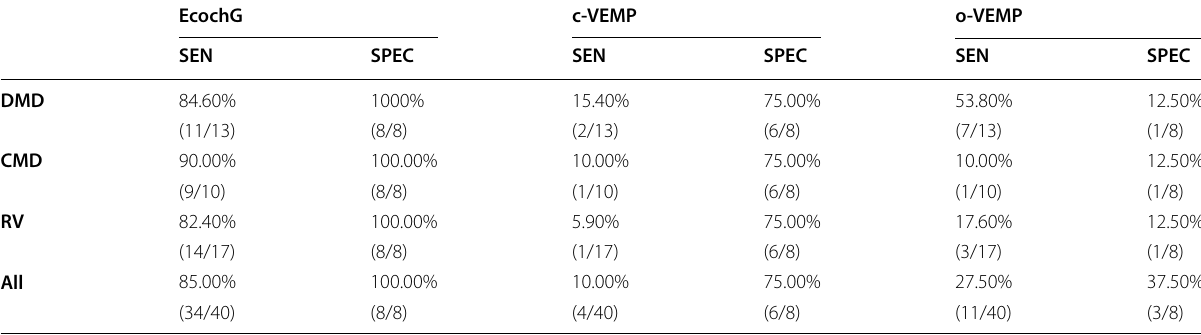
Table 18 Sensitivity and specificity of c-VEMP, o-VEMP, and ECochG